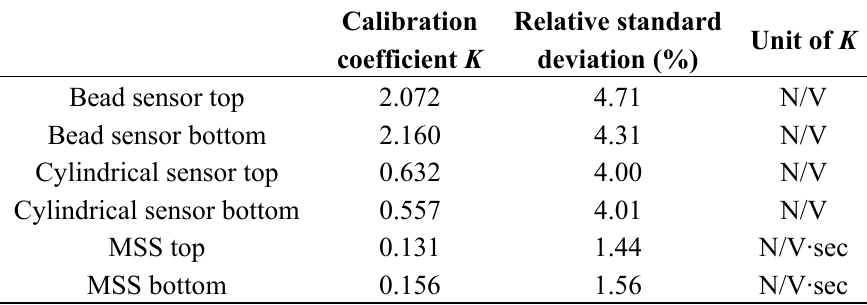
Table 1. Calibration coefficients adopted in this